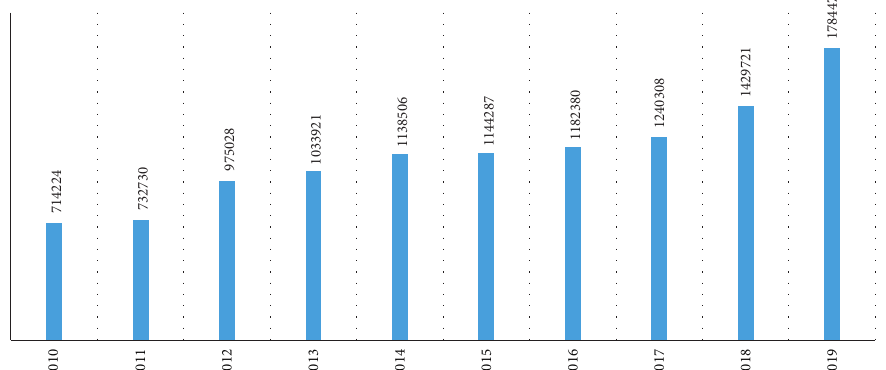
Figure 1: Dates global total import in tonnes for the period of 2010–2019. The data extracted from the International Trade Centre database [23].